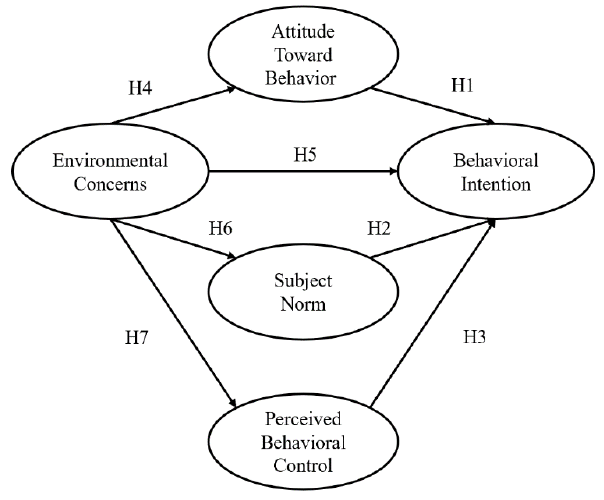
Figure 3. Research structure. Figure 3. Research